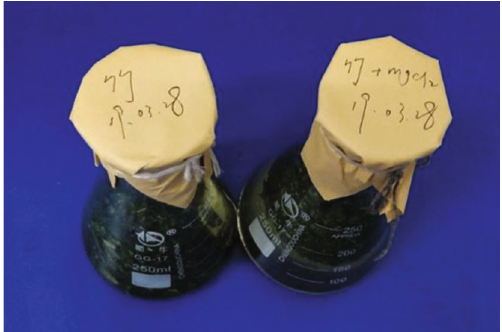
Figure 2: Extraction of chlorophyll from bamboo